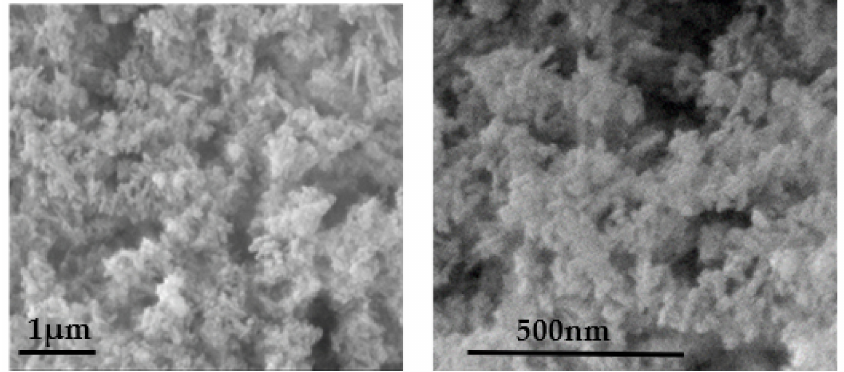
Figure 3. SEM micrographs of C-HAP material recorded at different